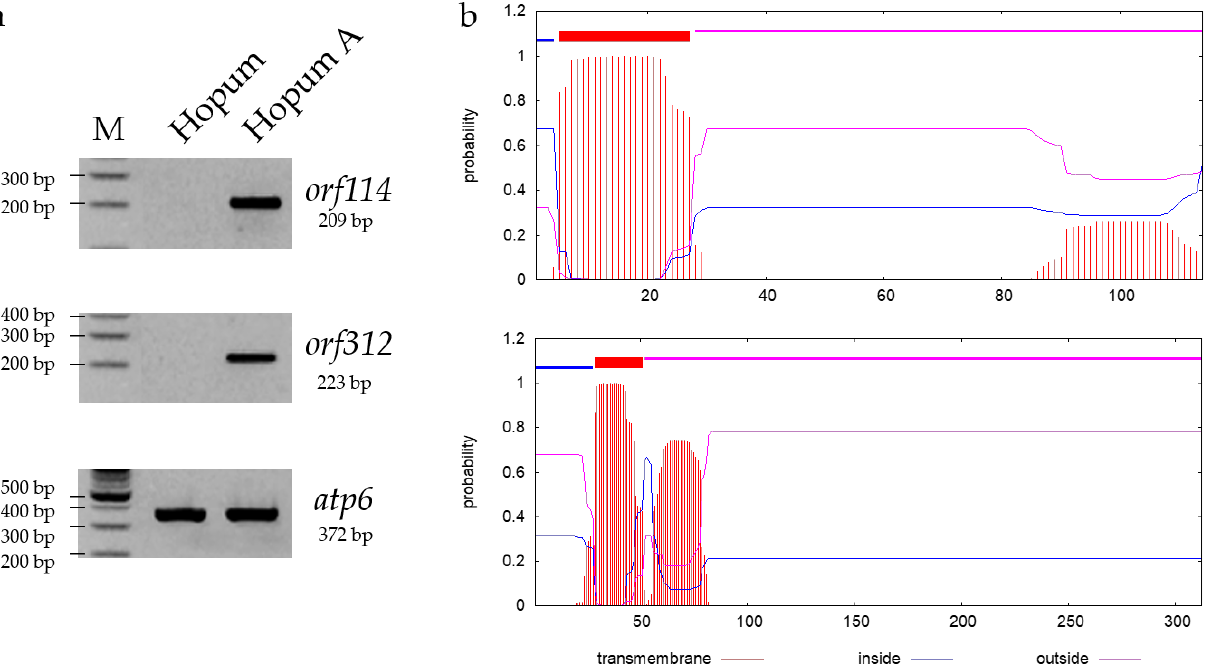
Figure 4. Candidate genes validation and transmembrane domains. ( a ) The RT-PCR results of orf114 and orf312 ; apt6 was used as the control; ( b ) transmembrane domain prediction results of ORF114 (up) and ORF312 (down). Protein sequences were analyzed using TMHMM server v.2.0 software. The output shows the location and probability associated with the predicted transmembrane domain.